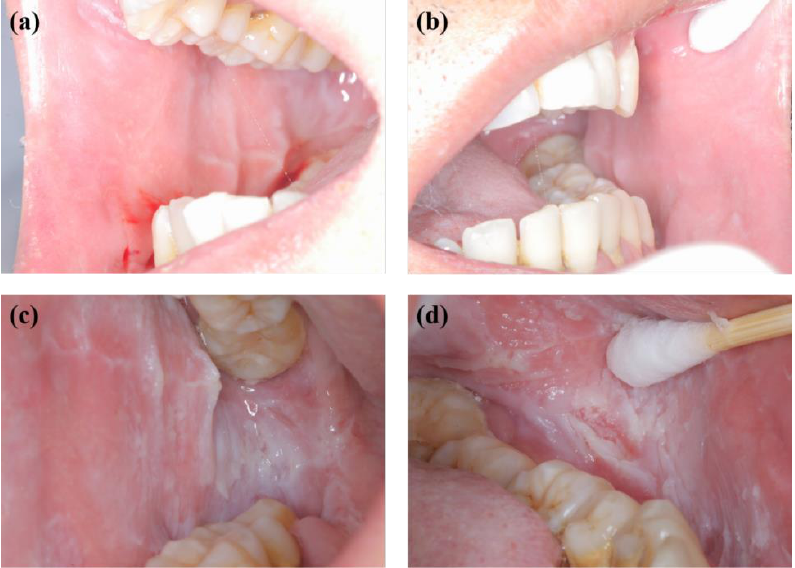
Figure 8. Oral mucosal examination for the proband’s father at follow-up showing significant reduction of lesions in the ( a ) right and ( b ) left buccal mucosa and a nearly complete disappearance of white corrugated plaques after one week and recurrence in the ( c ) right and ( d ) left buccal mucosa with greyish white corrugated folds and plaques after three months.